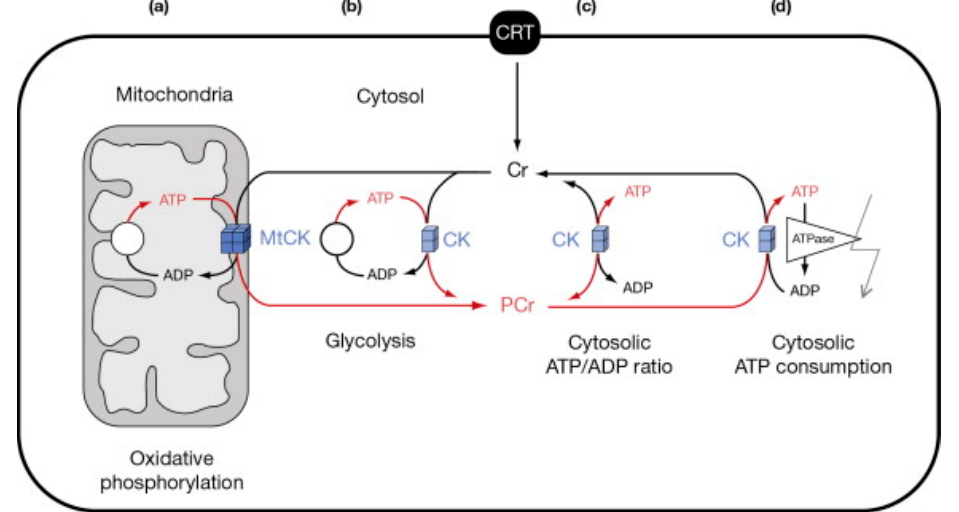
Figure 1. The CK/PCr system. Reprinted from Encyclopedia of Biological Chemistry, Vol 2, Schlattner, Figure 1. “The creatine kinase (CK) / phosphocreatine (PCr) system. Isoenzymes of CK (blue) are U., Tokarska-Schlattner, M., and Wallimann, T. Metabolite channeling: creatine kinase micro found in di ff erent compartments such as mitochondria (octameric MtCK, ( a )) and cytosol (dimeric compartments, 80–85, Copyright (2013), with permission from Elsevier Publishing Company. CK, ( b )–( d )) in soluble form ( c ) or associated to a di ff erent degree to ATP-delivering (( a ) and ( b )) or -consuming processes ( d ). A large cytosolic PCr pool up to 30 mM is built up by CK using ATP from oxidative phosphorylation like in heart ( a ) or glycolysis like in fast-twitch glycolytic muscle ( b ). PCr is then used to bu ff er global ( c ) and local ( d ) ATP / ADP ratios. In cells that are polarized and / or have very high or localized ATP consumption, these CK isoenzymes, together with easily di ff usible PCr, also maintain an energy shuttle between ATP-providing or -consuming processes (( a ) and ( d )). Metabolite channeling occurs where CK is associated with ATP-providing or -consuming transporters, pumps, or enzymes (( a ), ( b ), and ( d )). Creatine (Cr) is synthesized in only few cell types (e.g., liver and kidney) and has to be taken up from the blood stream by a specific Cr transporter (CRT) that is highly expressed by Cr-containing target cells.” Figure and legend reprinted from